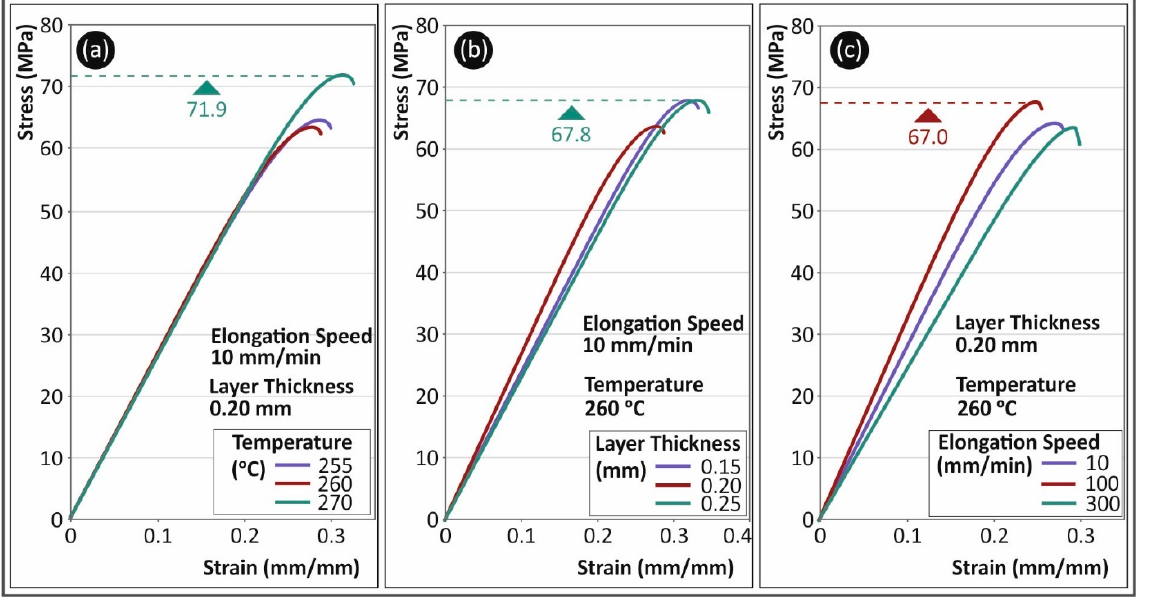
Figure 3. Stress (MPa) to strain (mm/mm) typical curves for PC material for ( a ) different 3D printing temperatures, ( b ) different layer thicknesses and ( c ) different elongation speeds.